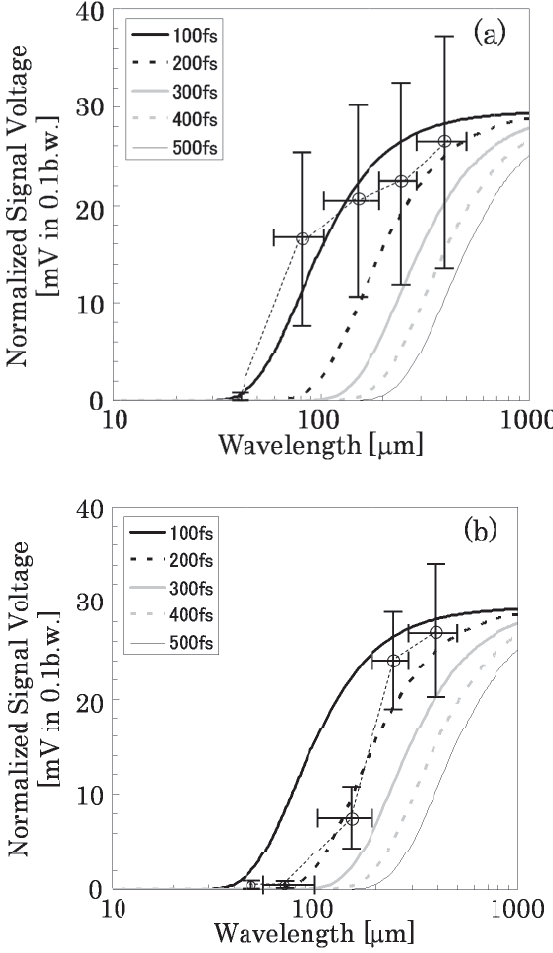
FIG. 6. Spectra of the transition radiation measured by a bolometer, generated from (a) quasimonoenergetic distributions peaked around 20 MeV, (b) quasimonoenergetic distributions peaked around 4 MeV. The circles show averaged signals of the transition radiation, placed at the middle of the detection ranges (determined by bandpass filters) shown by the horizontal error bars, and the vertical error bars describe these standard devia- tions. The calculated spectra of the transition radiation for different bunch duration are also